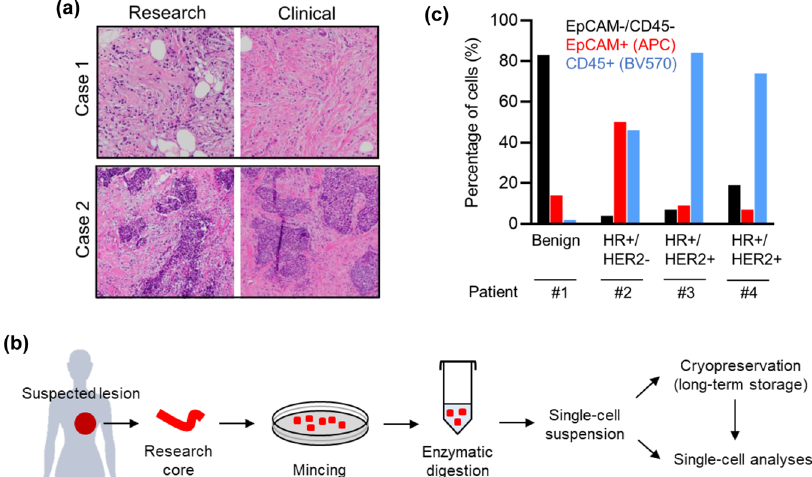
Fig. 2 Research core biopsy specimens are histologically concordant with clinical specimens and show expected cell subsets. a Histologic concordance of clinical and research core biopsy specimens. H&E staining of representative research core specimens (left) and the clinical core specimens (right), showing grade 2 invasive lobular carcinoma (Case 1; 20x magni fi cation) and grade 2 invasive ductal carcinoma (Case 2, 10x magni fi cation). b Work fl ow for the long-term storage and processing of fresh core biopsy specimens for multiple experimental applications. c Cell subsets identi fi ed in research core biopsies. Single-cell suspensions were generated from each research core, stained and sorted by fl ow cytometry, using EpCAM- and CD45-directed antibodies as markers of epithelial and immune cells,